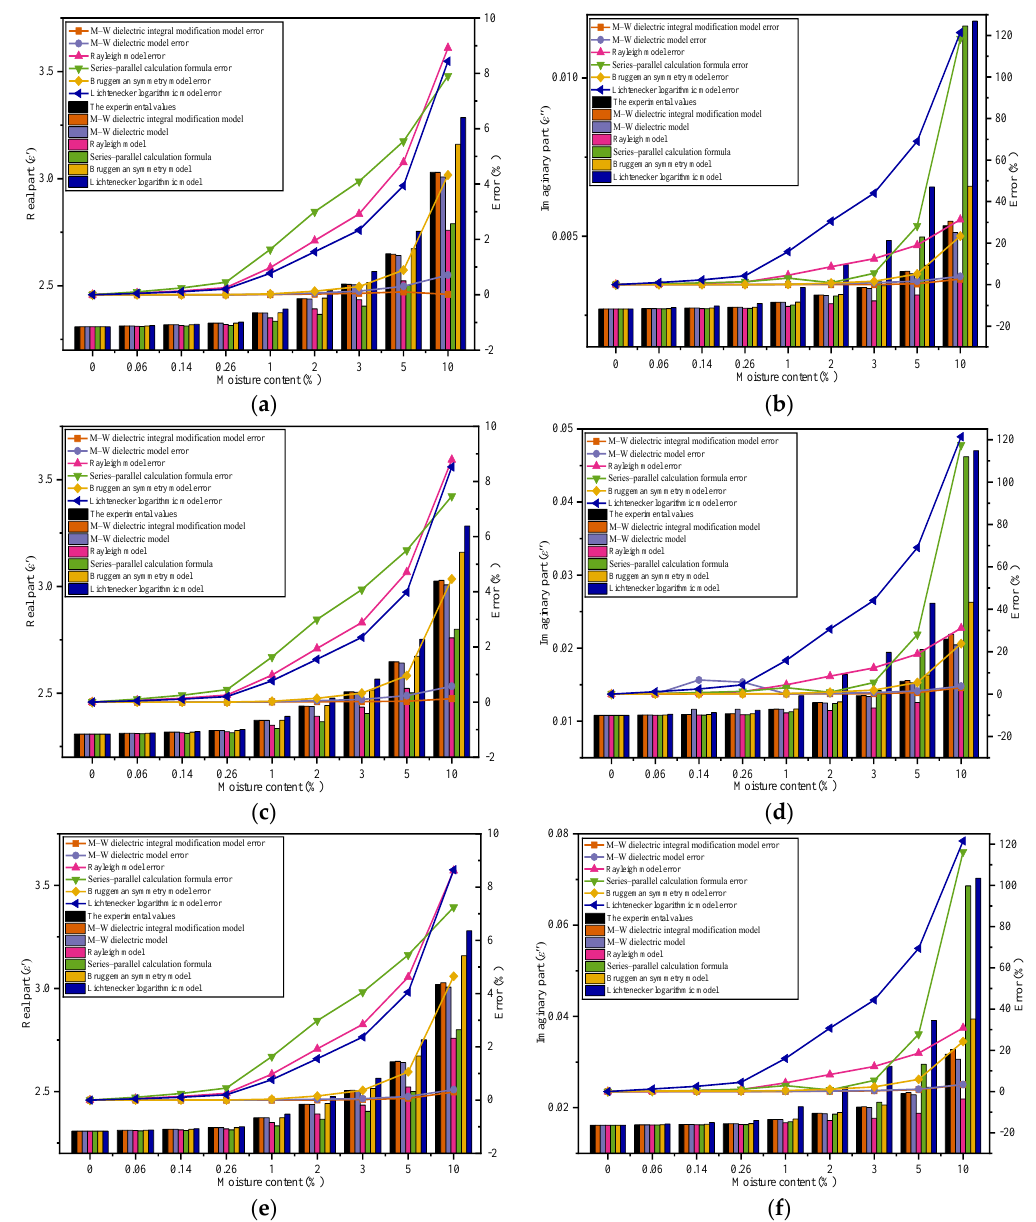
Figure 9. Comparison of different models at multiple frequencies: ( a , b ) f 1 = 0.5 GHz; ( c , d ) f 2 = 2 GHz; ( e , f ) f 3 = 3 GHz. According to Figure 9, for a given frequency, the error increases with increasing moisture content for all theoretical models. The M – W dielectric integral modification model has the slowest error growth trend and the smallest average error. The error of all theoretical models reaches its maximum value for a moisture content of 10%. errors of the M – W dielectric integral modification model, Bruggeman symmetry model, and Lichtenecker logarithmic model increase with increasing frequency, while the aver- age errors of the M – W dielectric model, Rayleigh model, and series-parallel calculation formula decrease. For the imaginary part of the dielectric constant, the average errors of